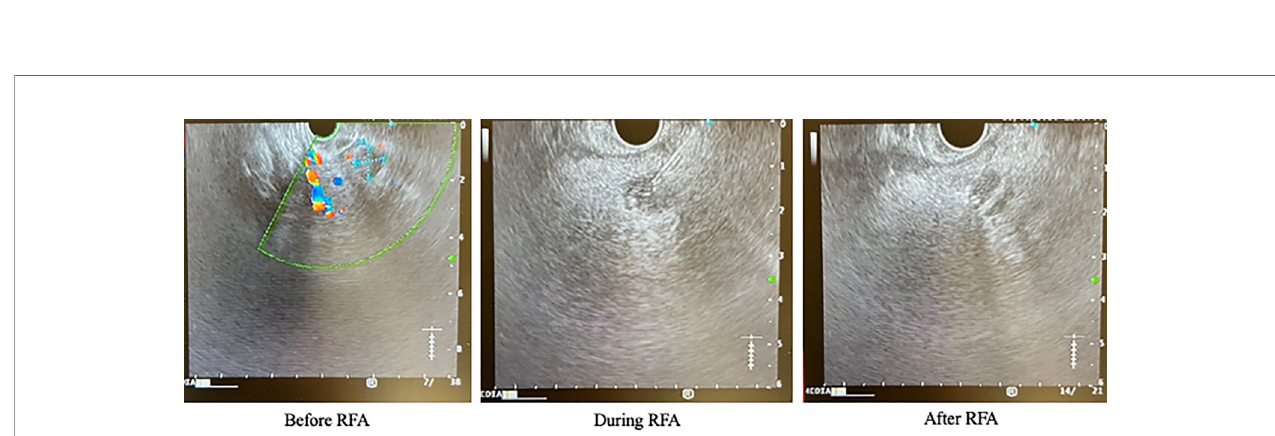
FIGURE 3 | Endoscopic ultrasound images of the patient before, during and after RFA. RFA, radiofrequency ablation.